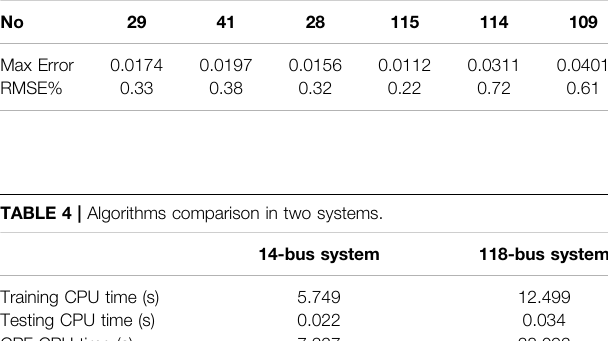
TABLE 3 | DNN performance with different buses.